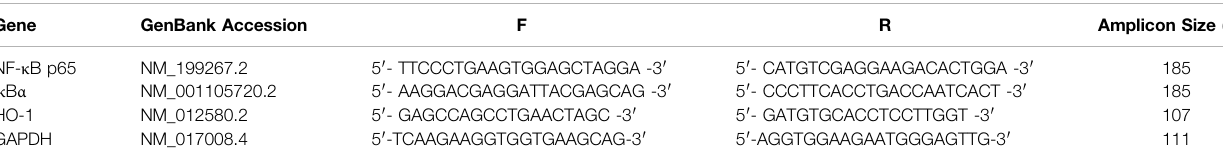
TABLE 5 | Primer sequences for qRT-PCR.